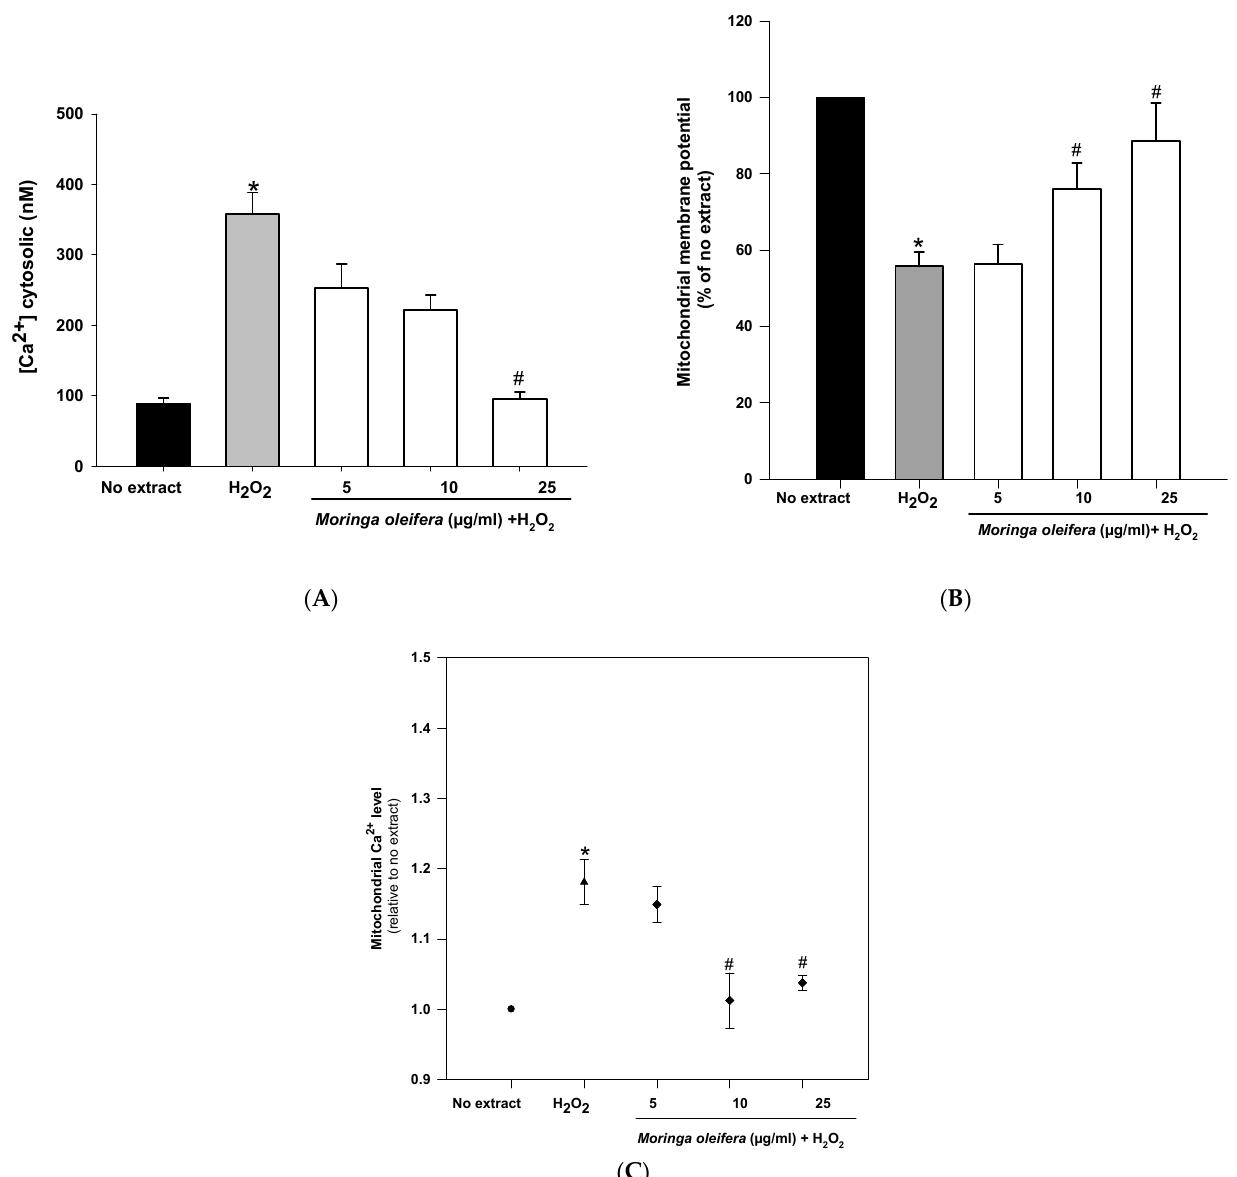
Figure 5. Effect of methanol extracts of Moringa oleifera leaf powder on ( A ) mitochondrial membrane potential ( B ) levels of cytosolic calcium and ( C ) levels of mitochondrial calcium. Cells were pretreated with moringa (5, 10 and 25 µg/mL) for 24 h before 100 µM H 2 O 2 for 1 h. * p < 0.05 versus no extract, # p < 0.05 versus H 2 O 2.